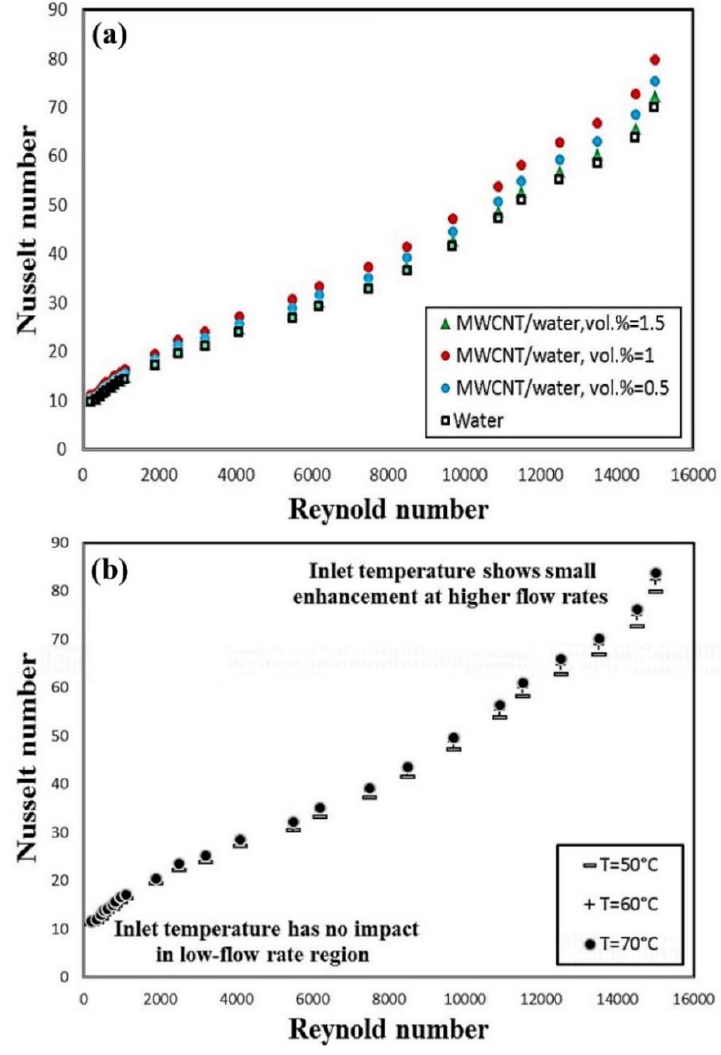
Figure 10. ( a ) Variations of Nu number of the nanofluid and water versus Re number, and ( b ) Variations of the Nu number versus Re number in different inlet fluid temperature. Reproduced with permission from [181]. Elsevier, 2016.